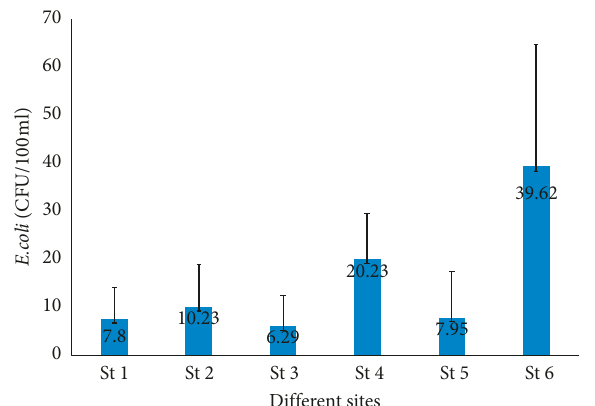
Figure 2: Abundance of E. coli in the different sampling sites of Fresco lagoon.